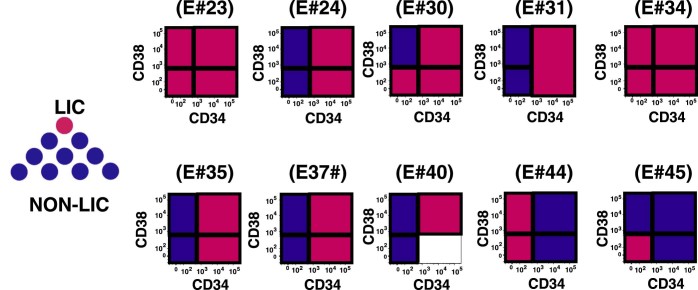
Schematic LICs (red) and NON-LIC (blue) phenotype repartition based on CD34 CD38 for 10 AML samples. AML cells were sorted based on the CD34 and CD38 expression and injected in NSG mice (n = 3 to 8 animals per gate tested). Fraction was scored as enclosing LICs if a distinct human single CD45+CD33+CD19− population was detectable in the recipient bone marrow. For E#40 CD34+CD38− quadrant was not tested since no cells harbored this phenotype.